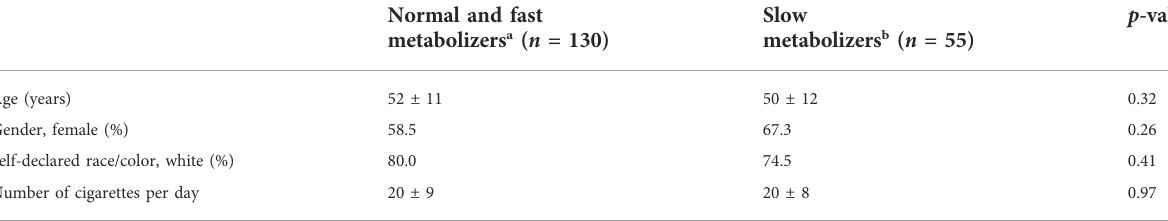
TABLE 1 General characteristics of the total group of patients, according to NMR.